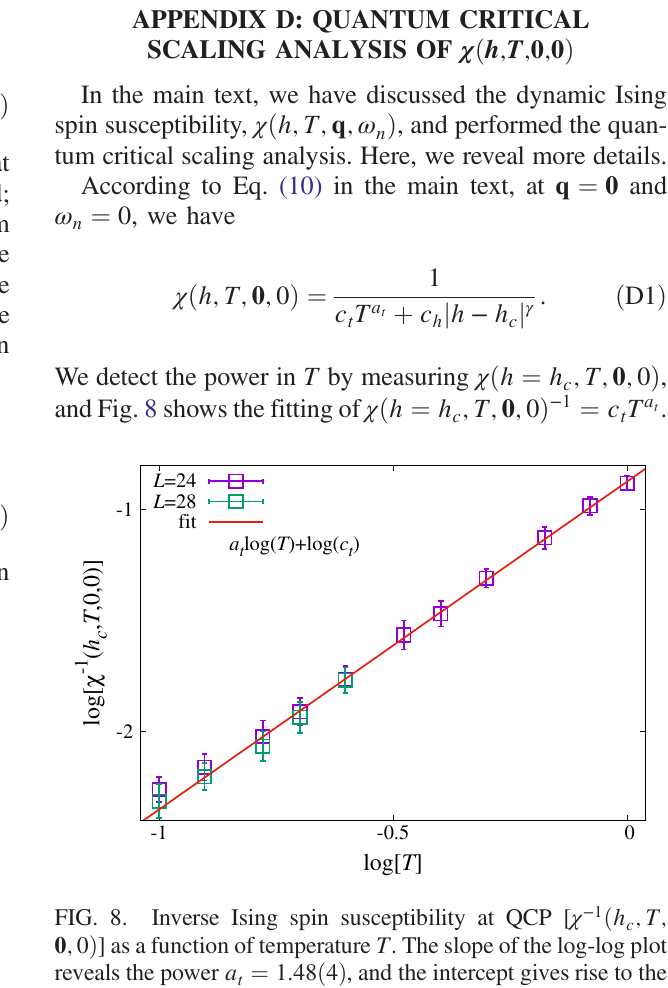
FIG. 6. Finite-temperature FM-to-PM phase transition at T ¼ 0 . 5 . Panel (a) shows the Ising spin susceptibility at q ¼ 0 and ω n ¼ 0 , and panel (b) shows the data collapse according to Eq. (C1). Note that h N is a free fitting parameter, and the best data collapse gives h N ð T ¼ 0 . 5 Þ ≈ 3 . 06 .